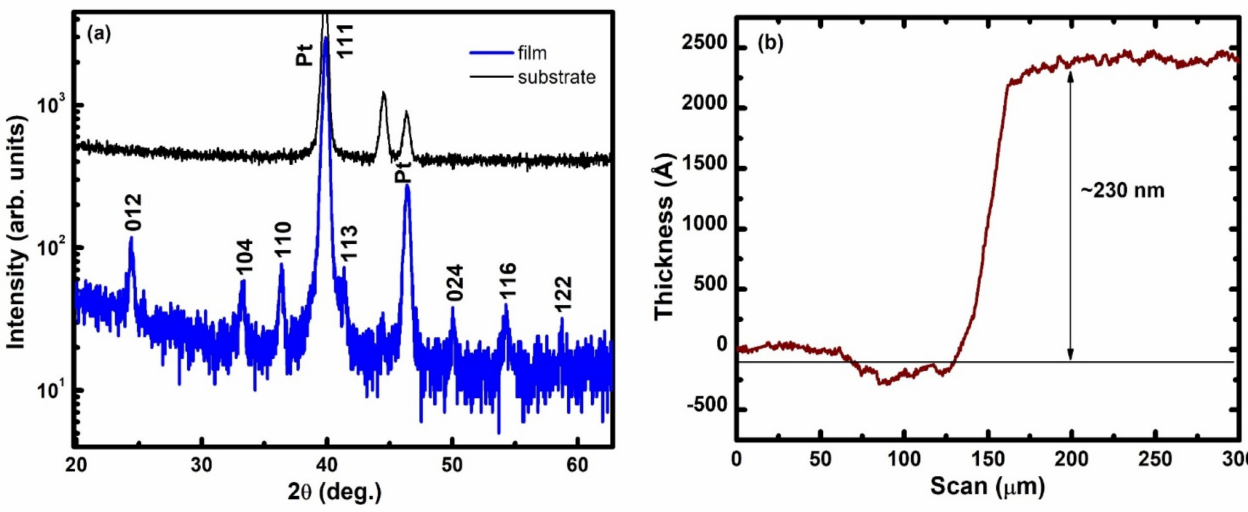
Figure 1. ( a ) X-ray diffraction pattern of the Si/SiO 2 /Ti/Pt substrates and V 2 O 3 thin films grown on the substrates; ( b ) a profilometer-based scanned profile of the thin films’ surface indicates that the thickness of the films are ~230